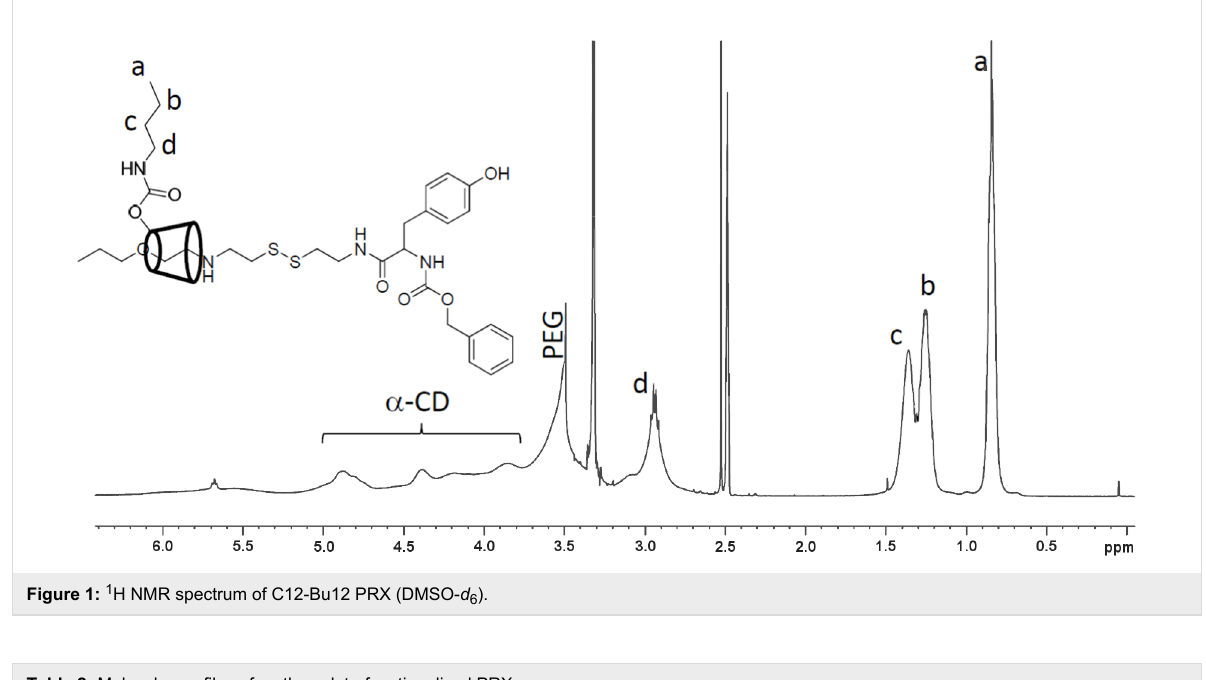
Table 2: Molecular profiles of methacrylate-functionalized PRXs.